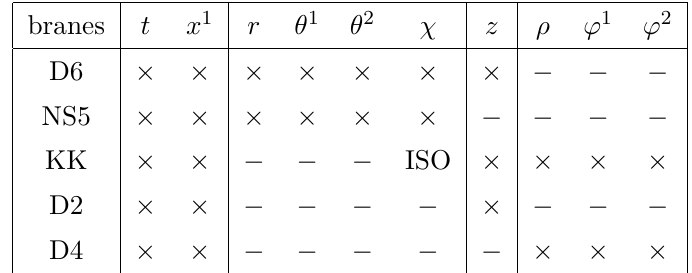
Table 2 . Brane picture underlying the D2-D4 branes ending on the NS5-D6-KK intersection. The system is BPS / 8